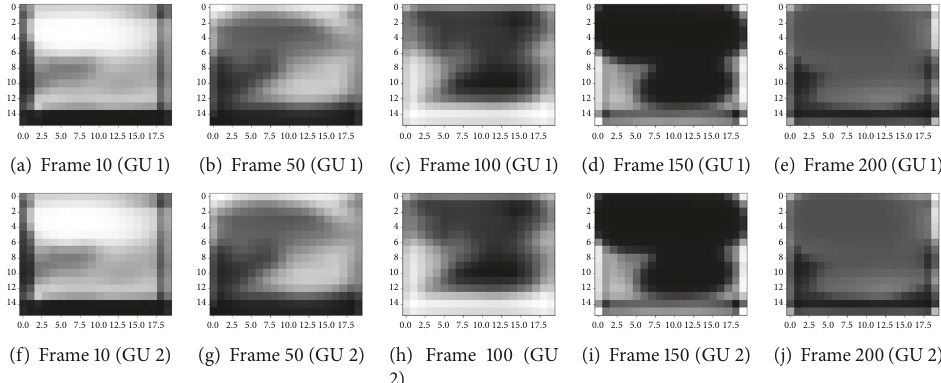
Figure 19: Representation in GU Units (Layer 2) (Construction